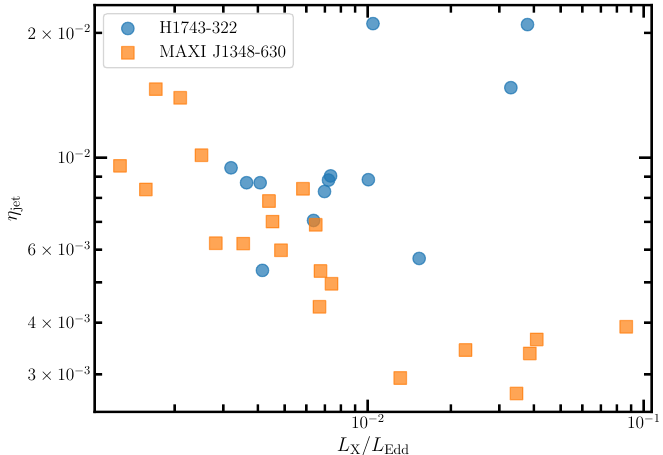
Figure 7. Distribution of the jet efficiency versus the 1–10 keV X-ray Eddington ratio L X / L Edd in the ‘outlier’ track. The blue circles represent H1743-322 and orange squares represent MAXI